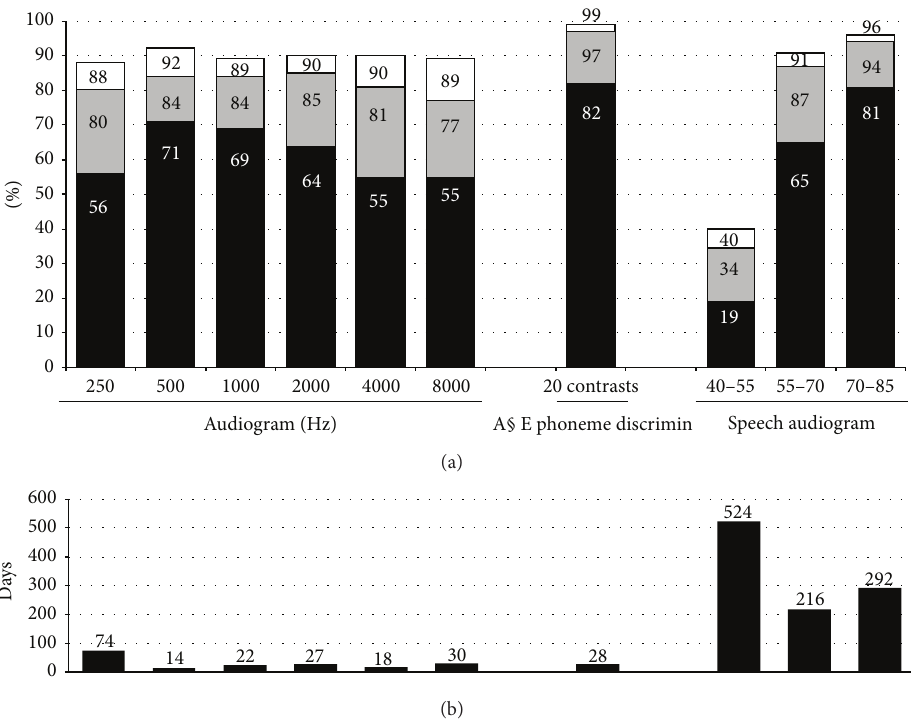
Figure 1: (a) shows the percentages of CI-users who performed on target (THR) at initial testing (black), final testing (gray), and almost on target (tTHR) at final testing (white) on Audiometry, A§E phoneme discrimination (A§E phoneme discrimin), and Speech Audiometry. Part (b) shows the interval between the initial and final measurement for those CI-users who did not reach target at the latest measurement.